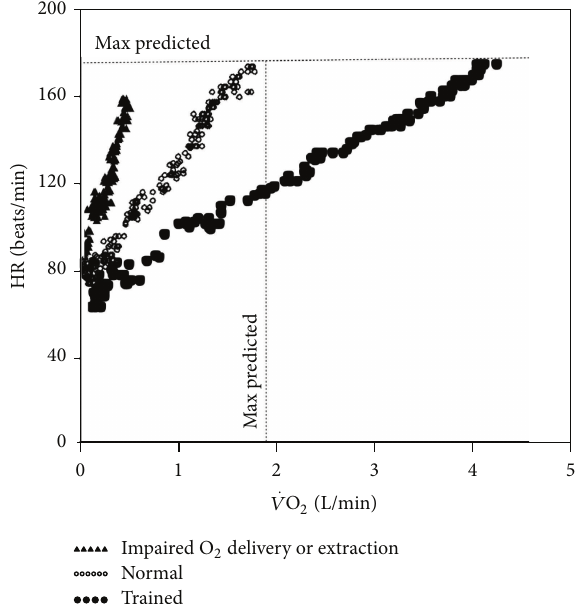
̇𝑉 ) O 2 ̇𝑉 = O 2 ̇𝑉 = 65 beats/L), O 2